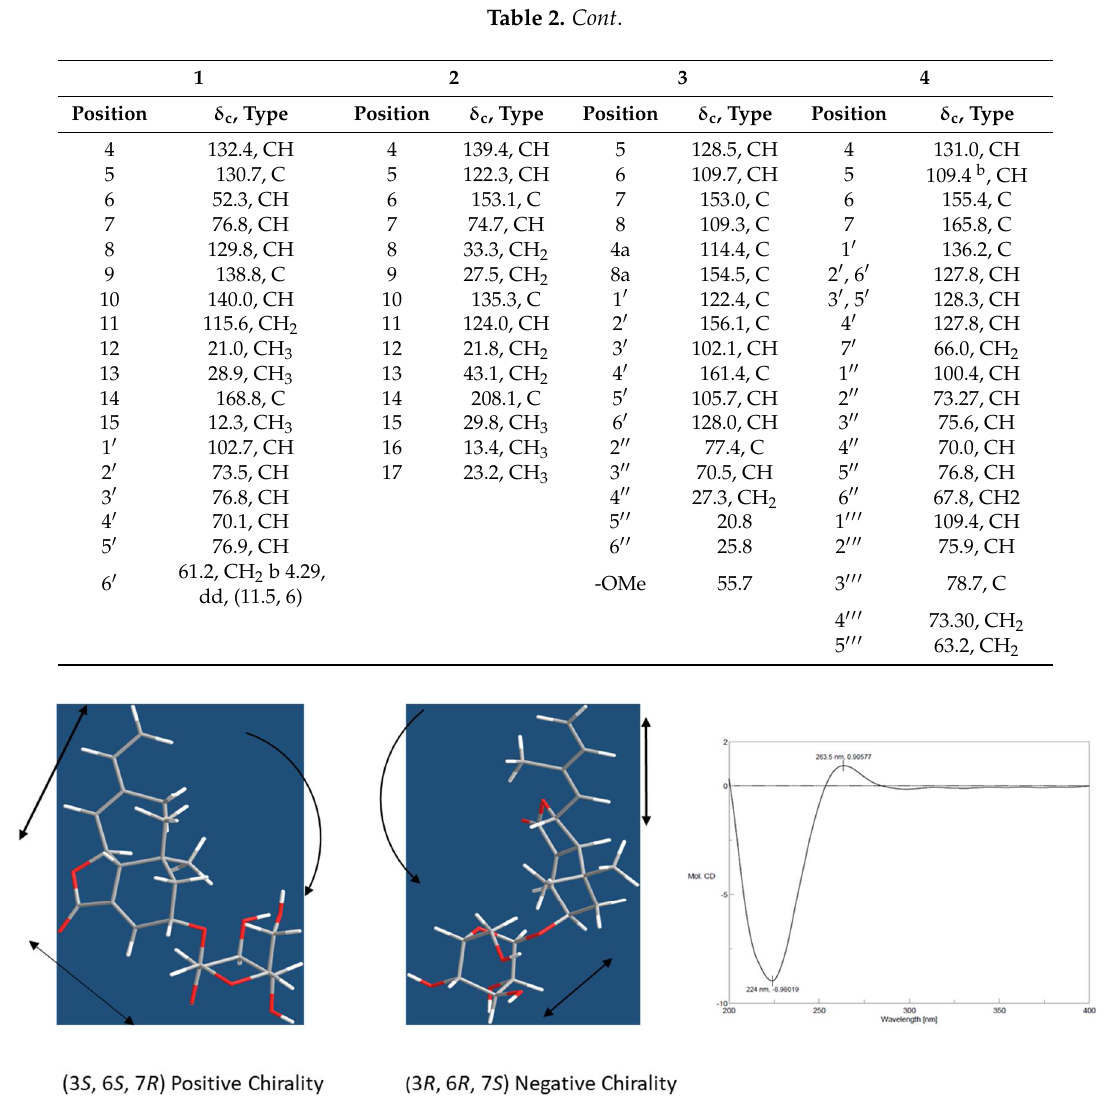
Figure 2. ECD Spectrum of compound 1. The positive Cotton effect of ECD spectrum is in agreement with the negative chirality of (3 S , 6 S , 7 R ) diastereoisomer of compound 1.